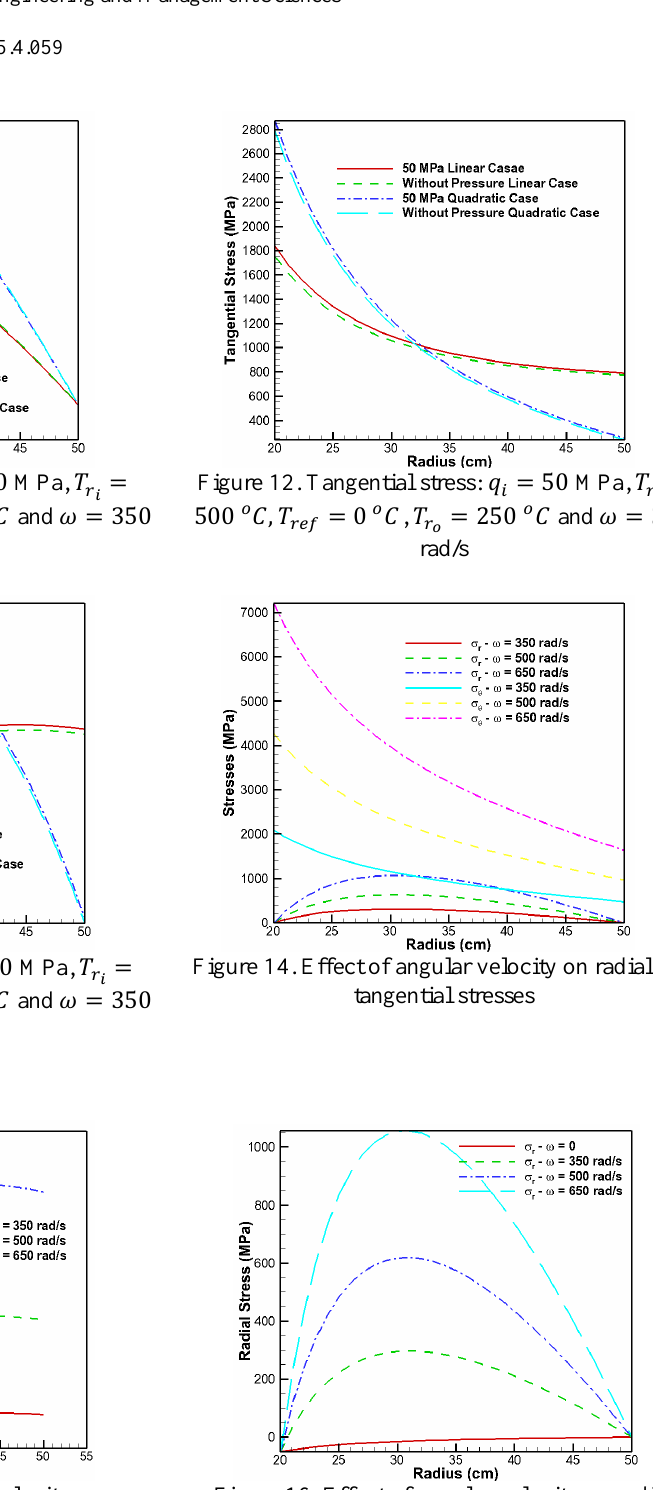
Figure 15. Effect of angular velocity on displacement